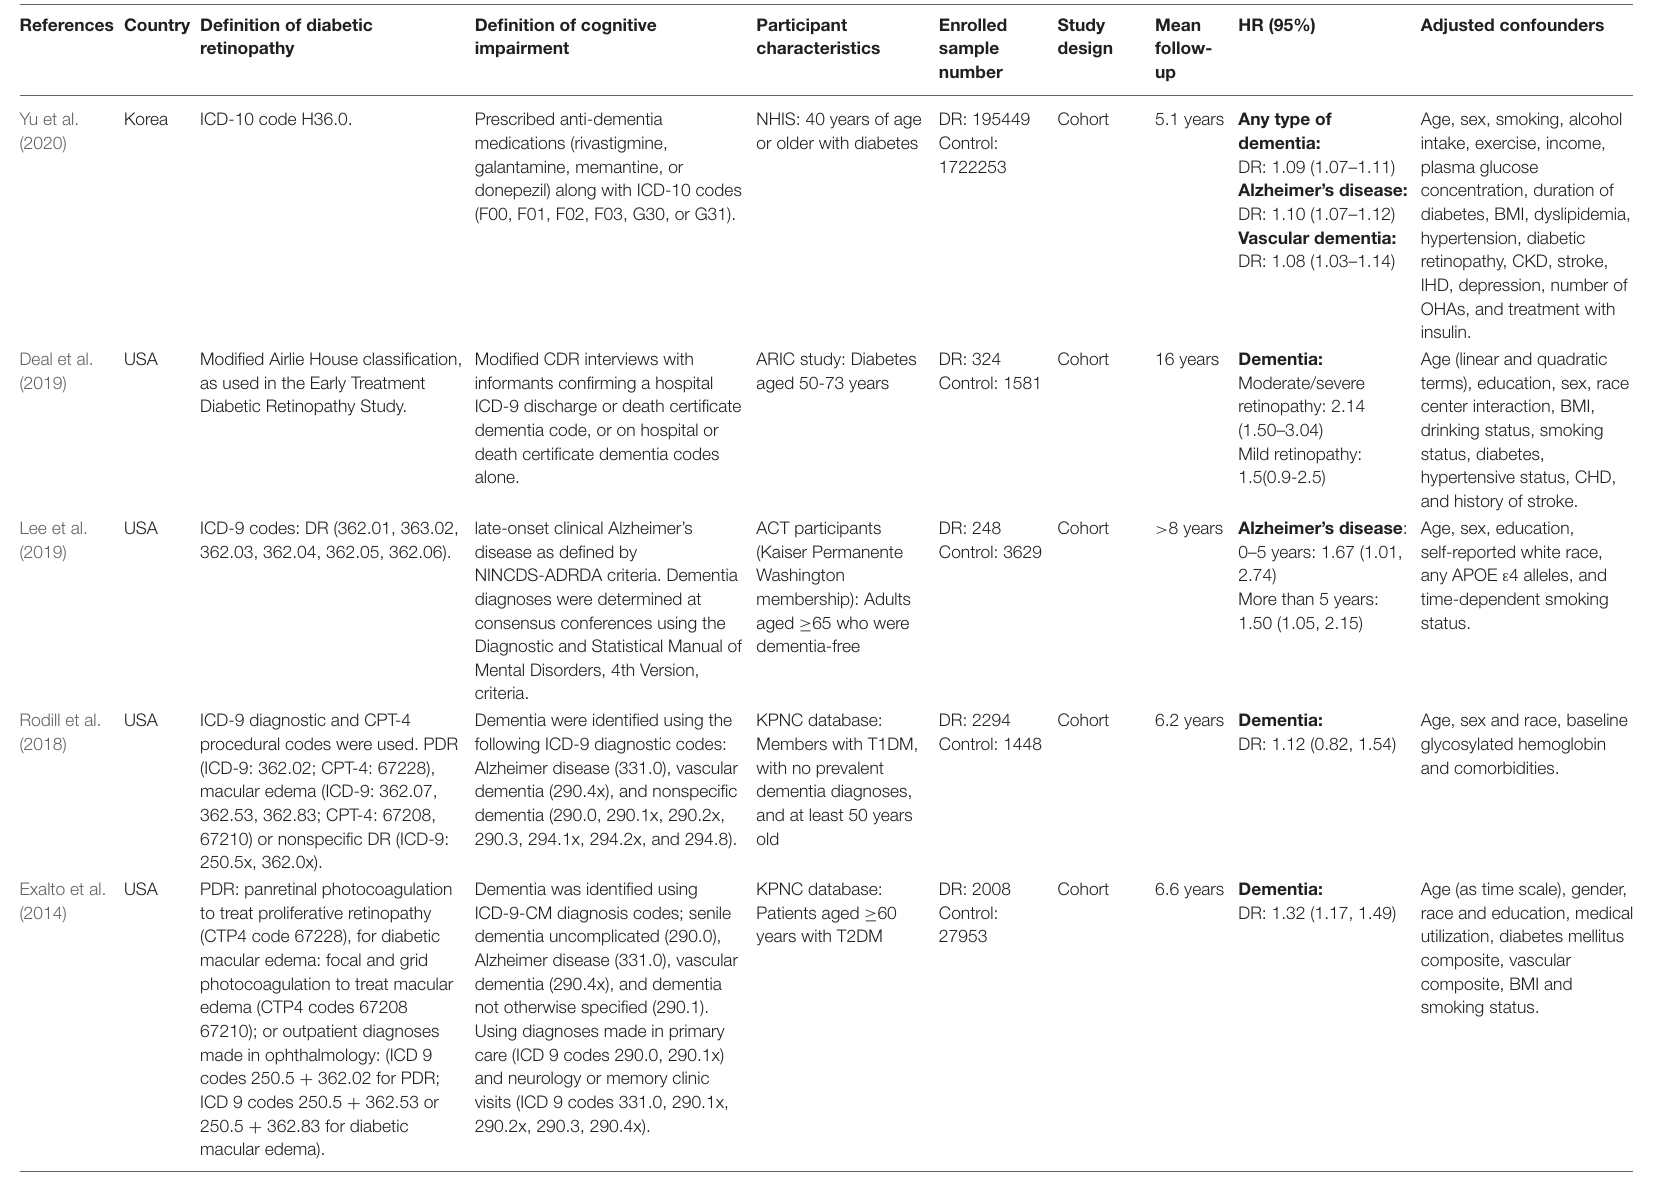
TABLE 2 | Characteristics of the study providing hazard